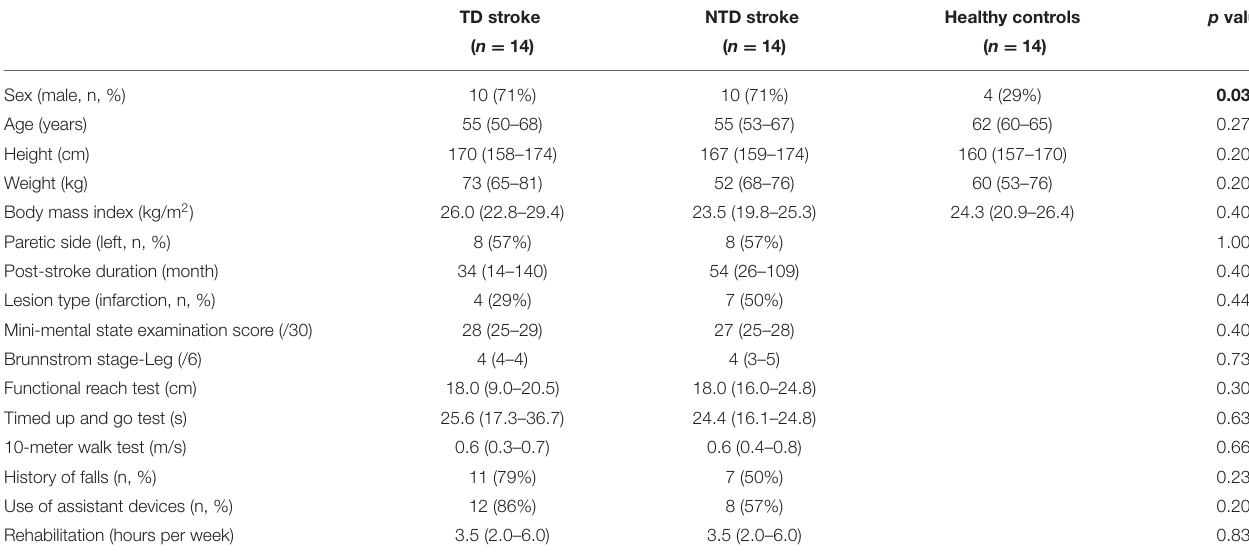
TABLE 1 | Demographic and physical characteristics of participants with stroke and healthy controls. TD stroke NTD stroke